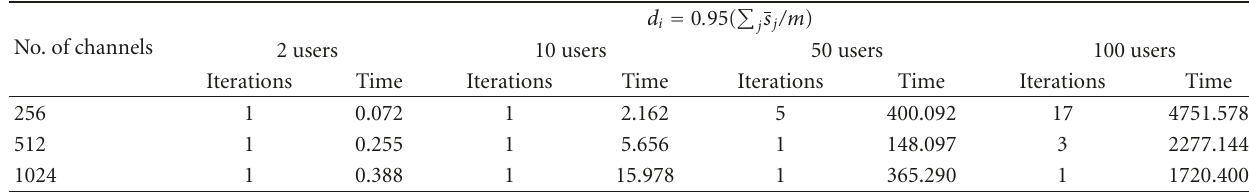
Table 3: Number of iterations and CPU time (seconds) required to achieve the budget allocation where the competitive equilibrium satisfies (cid:6) ) in large-scale problems by the iterative method, error tolerance = 0.05 and average of 10 simulation runs. power demands d i = 0 . 95( j s j /m